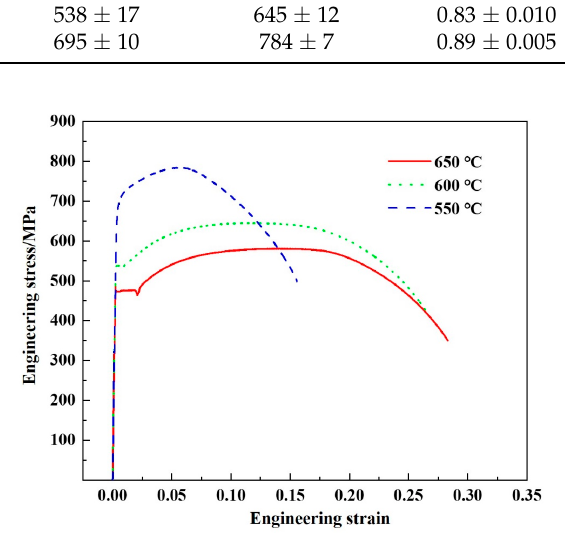
Table 2. The mechanical properties of test steel at di ff erent coiling temperatures.